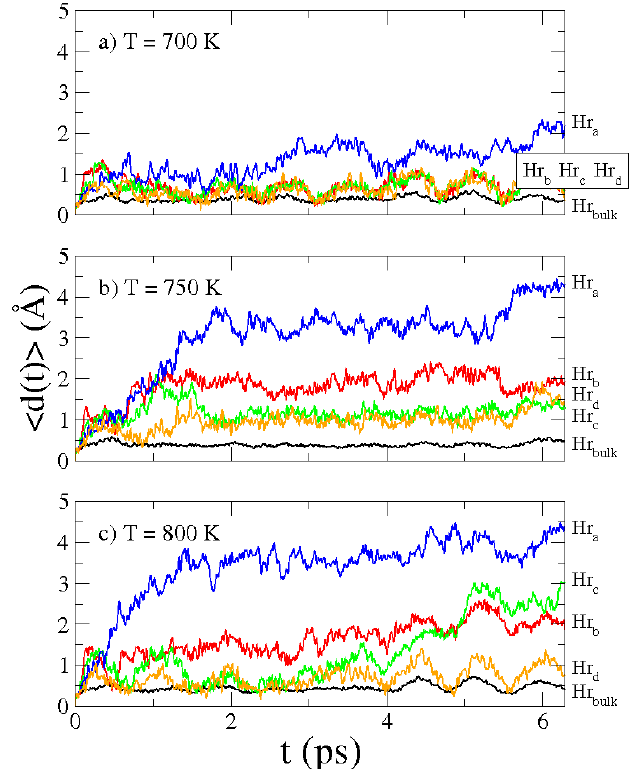
Figure 7. Average displacements ⟨ d ( t ) ⟩ of the group of H atoms Hr line), Hr (green line), Hr c